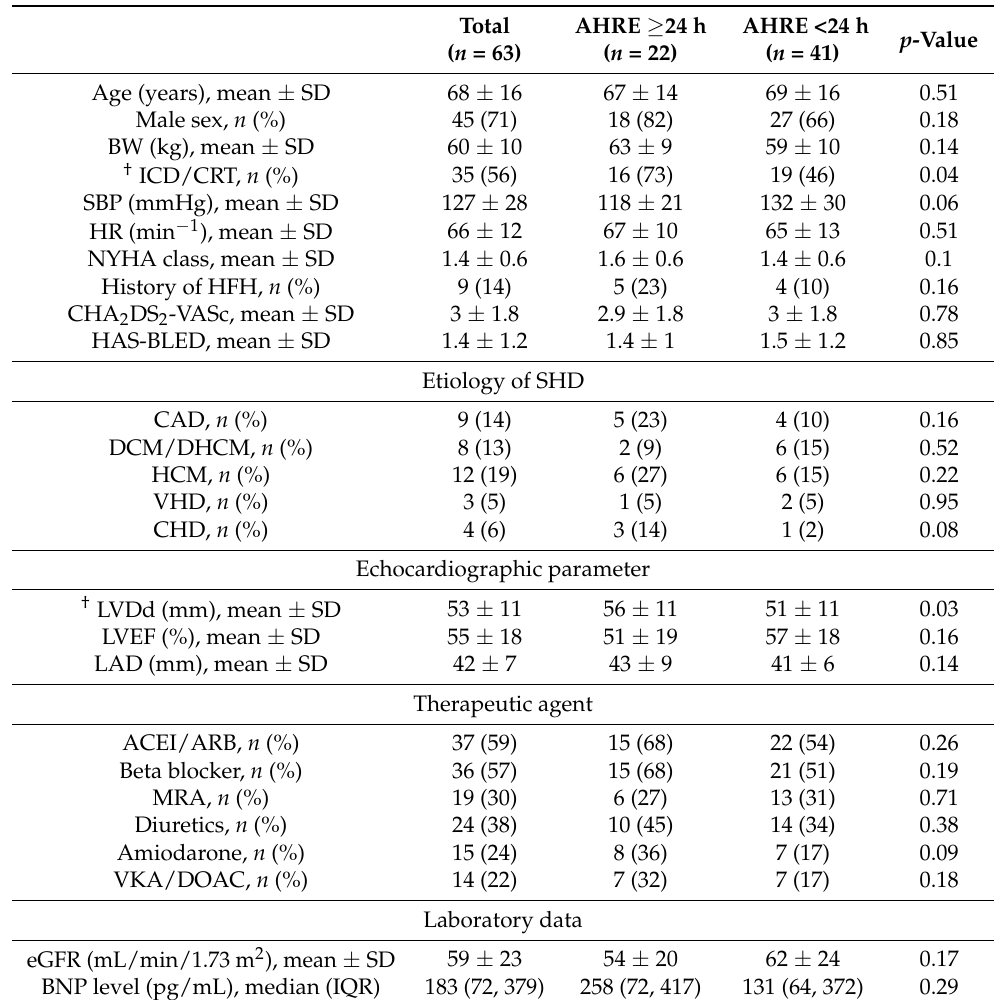
Table 1. Comparison of demographics between patients with AHRE ≥ 24 h and <24 h in patients without a history of AF.